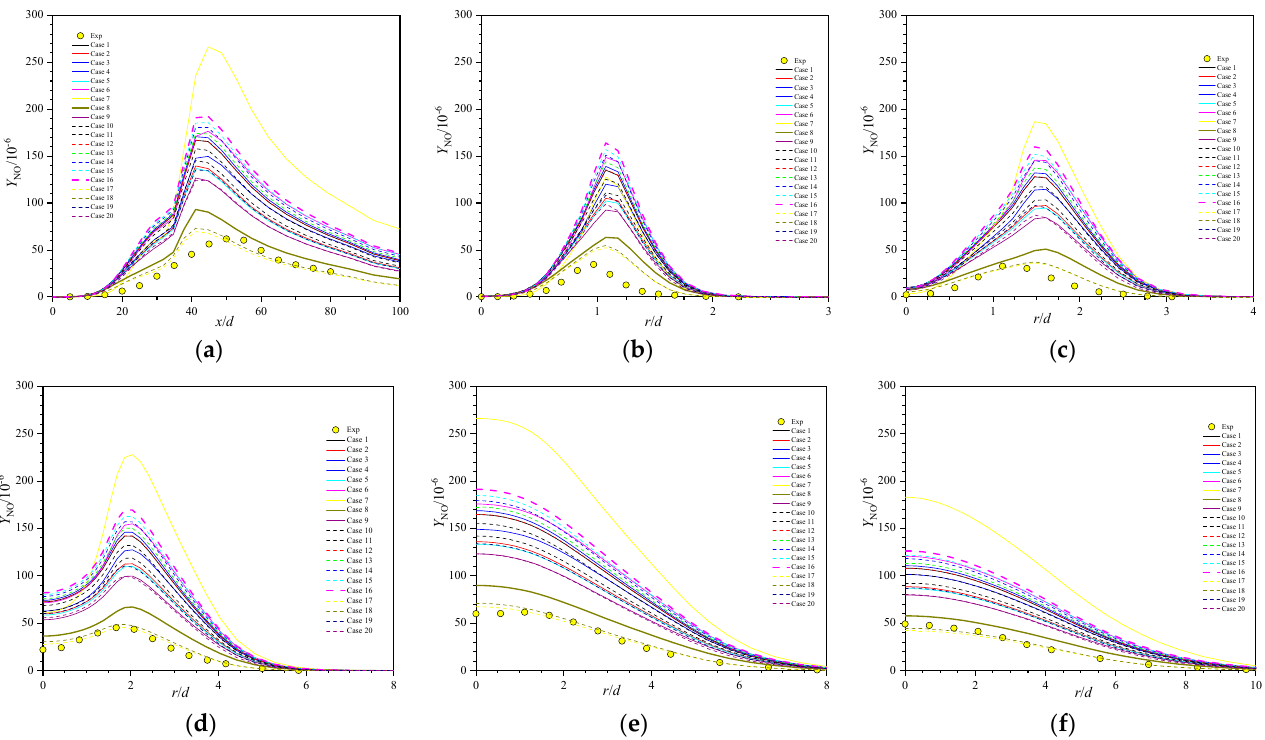
Figure 13. Comparison of measured [22,24] and predicted mean NO mass fraction profiles for the Sandia Flame D with 20 combinations of the primary EDC constants C D1 and C D2 . ( a ) @axis. ( b ) @ x / d = 7.5. ( c ) @ x / d = 15. ( d ) @ x / d = 30. ( e ) @ x / d = 45. ( f ) @ x / d = 60. The prediction of OH is particularly challenging due to the strong nonlinearity of the species’ evolution [44]. Compared to the respected measured data, the level of agreement for OH was subpar, with largely over-predicted peaks using all of the EDC constants. All results were found to significantly over-predict around the peak value locations where the mixtures burn intensely, as shown in Figure 14. However, the results of the peak value locations and the varied tendency are correctly predicted. The calculated maximum mass fractions are significantly over-predicted in comparison to the measured data. Large de- viations among the cases are found for the mean OH mass fractions. Among the cases with the primary constant 𝐶 (cid:2888)(cid:2870) in the limits, the result of case 16 is the upper profile limit, and case 8 is the lower profile limit. Results of other cases are within the limits of cases 8 and 16 except for cases 7 and 17–20.